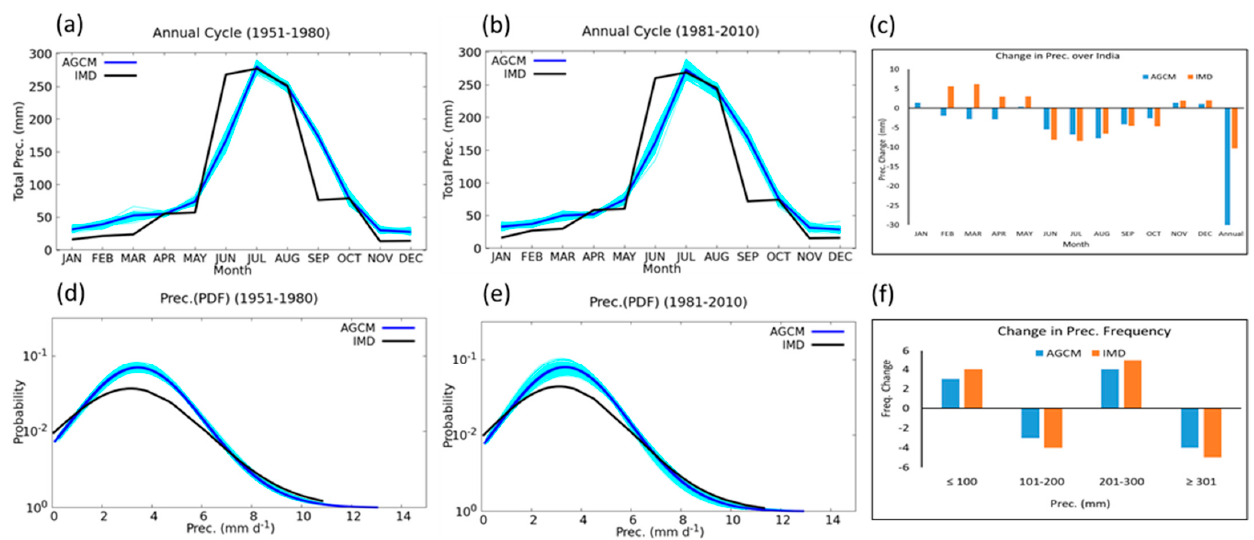
Figure 8. ( a , b ) Annual cycle, and ( d , e ) PDFs of precipitation. Change in ( c ) precipitation and ( f ) frequency in two climate periods. Thin lines in ( a – d ) correspond to the results for each individual member.